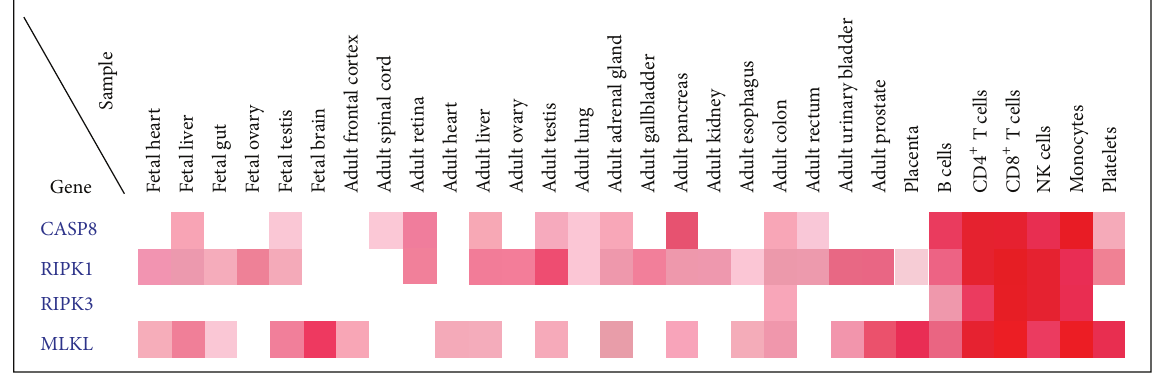
Figure 3: Expression of caspase-8, RIPK1, RIPK3, and MLKL in fetal and adult organs and hematopoietic and myeloid cells. Each row corresponds to each protein concentration displayed as white (no expression) to red color intensity. The heat map was obtained from